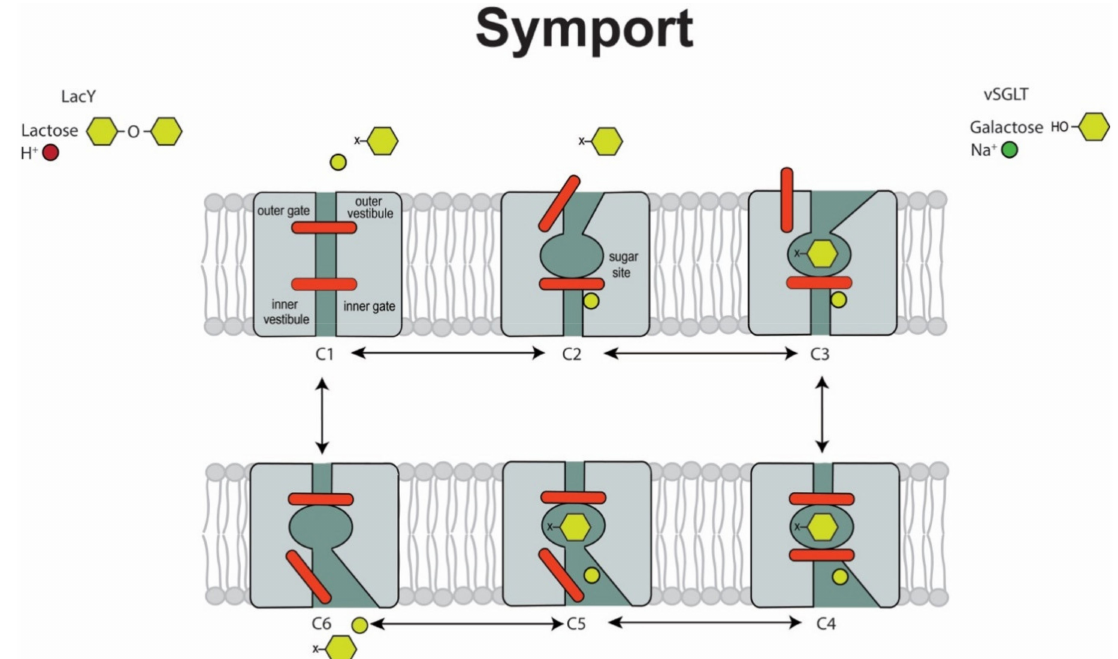
Figure 1. A model for H + /lactose and Na + /glucose transport by LacY and vSGLT . The transporters are shown as double- gated integral membrane proteins with a minimum of 6 states that undergo a series of ordered reversible reactions that drive inward sugar transport. The first step is the binding of external cation (H 3 O + O or Na + O) that results in the opening of the external gate (C1 to C2) to allow sugar to bind (C2 to C3). This is followed by closure of the external gate to occlude the bound sugar from both sides of the membrane (C3 to C4). The subsequent opening of the internal gate permits the release of sugar and cation into the cytoplasm (C5 to C6) and the return of the protein into the initial conformational state (C6 to C1). The net result is the obligatory coupling of the inward transport of one cation and one sugar molecule across the membrane into the cell. The rate and direction of sugar transport depends on the concentrations of ions (proton or sodium) on each side of the membrane, and the voltage across the